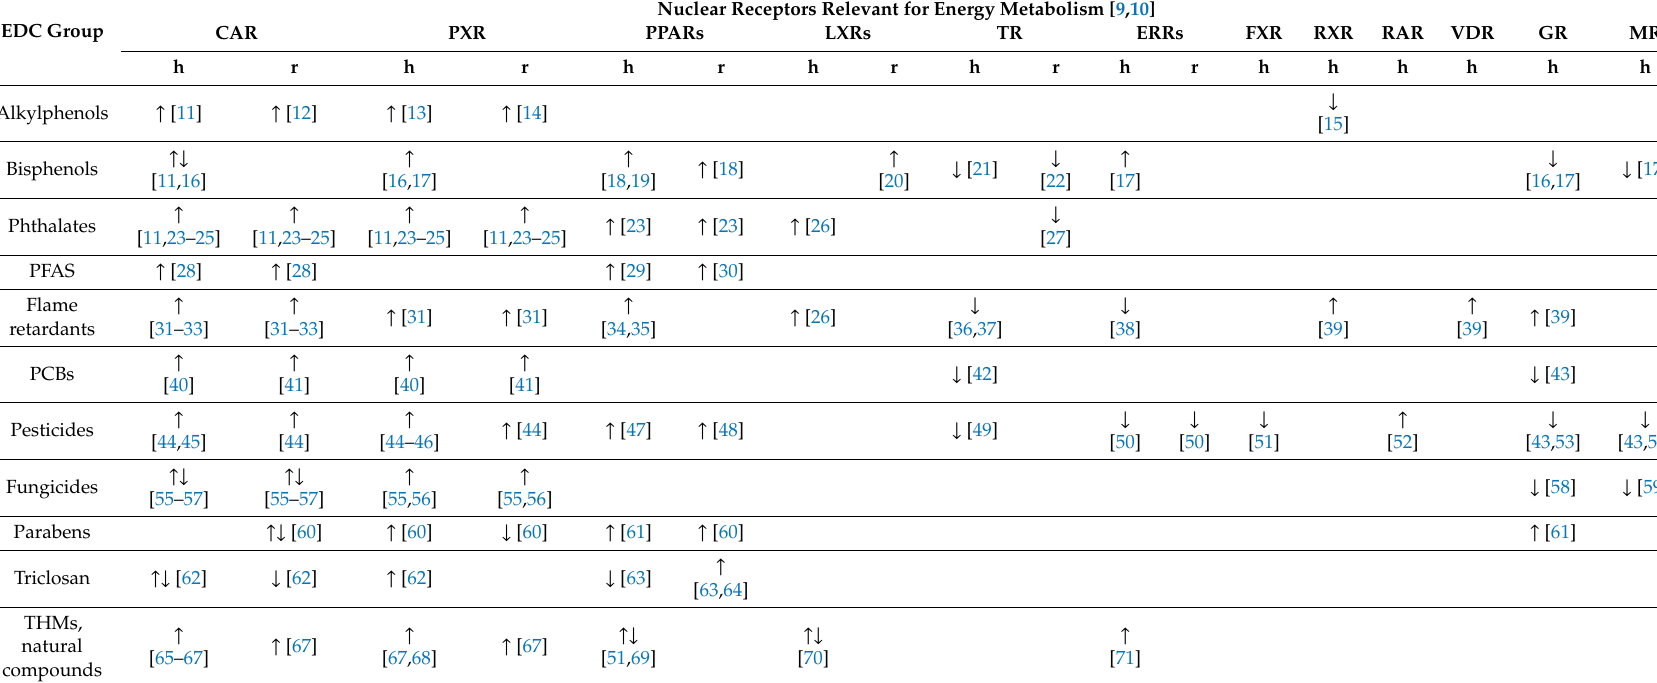
Table 1. Modulation of nuclear receptor activities by CAR-relevant